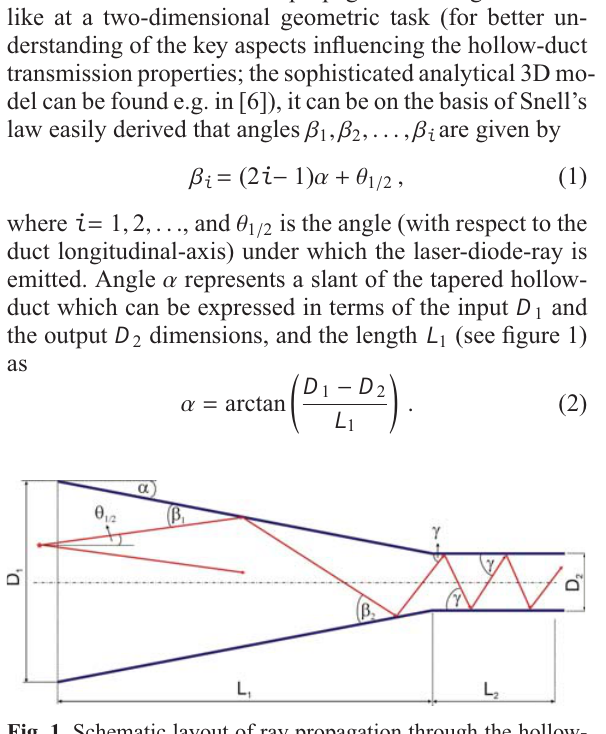
Fig. 1. Schematic layout of ray propagation through the hollow-